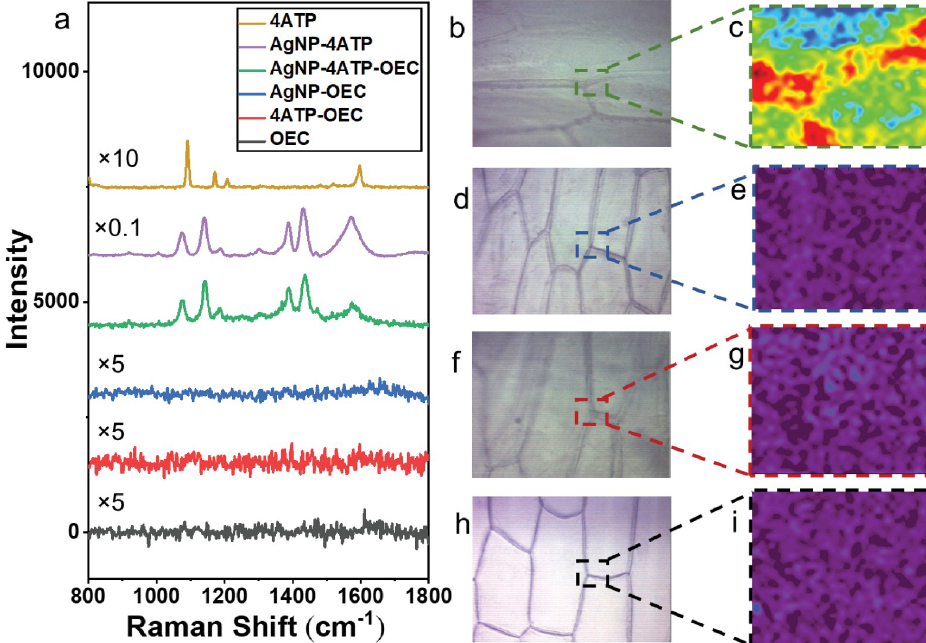
Fig 4. The Raman spectra and Raman images of samples with different treatments. The typical Raman spectra collected from bulk 4ATP, AgNP-4ATP complex, AgNP-4ATP-OEC, AgNP-OEC, 4ATP-OEC and freshly peeled OEC (a). The optical images and Raman images of scanned area created from AgNP-4ATP-OEC (b),(c), AgNP-OEC (d), (e), 4ATP-OEC (f), (g) freshly peeled OEC (h), (i), respectively. The Raman images were created with